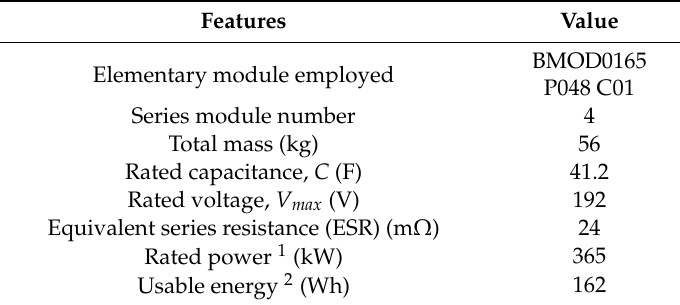
Table 6. Supercapacitor storage